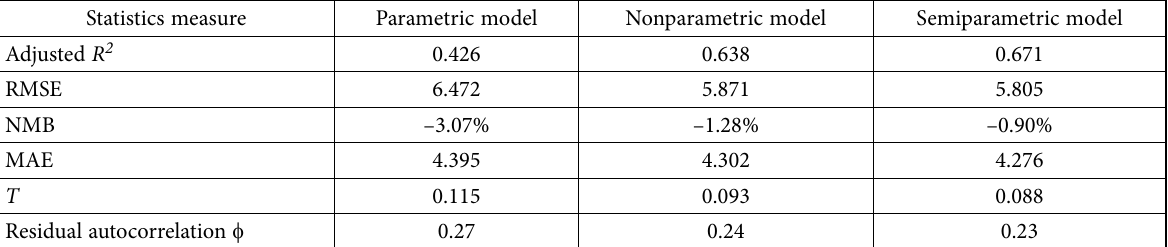
Table 4. Descriptive statistics of parametric, nonparametric and semiparametric models for estimation Statistics